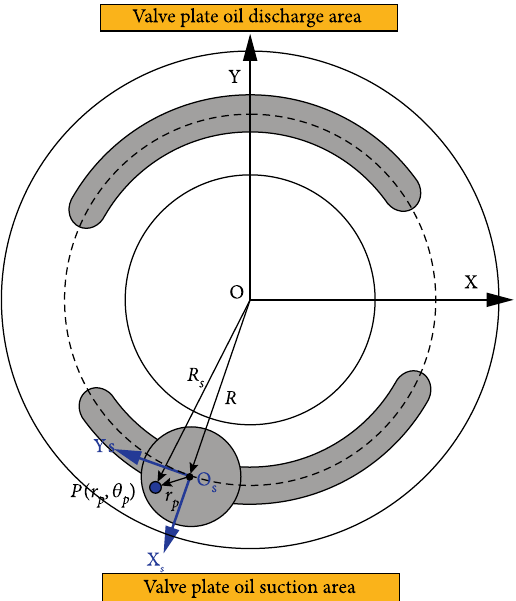
Figure 1: Schematic diagram of oil location in plunger